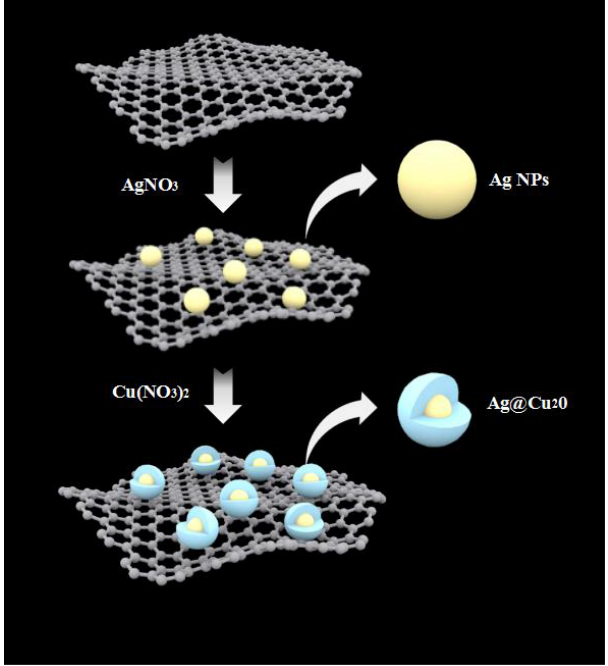
Figure 1. Schematic of the synthetic procedure for Ag@Cu 2 O-reduced graphene oxide (rGO) nanostructures.